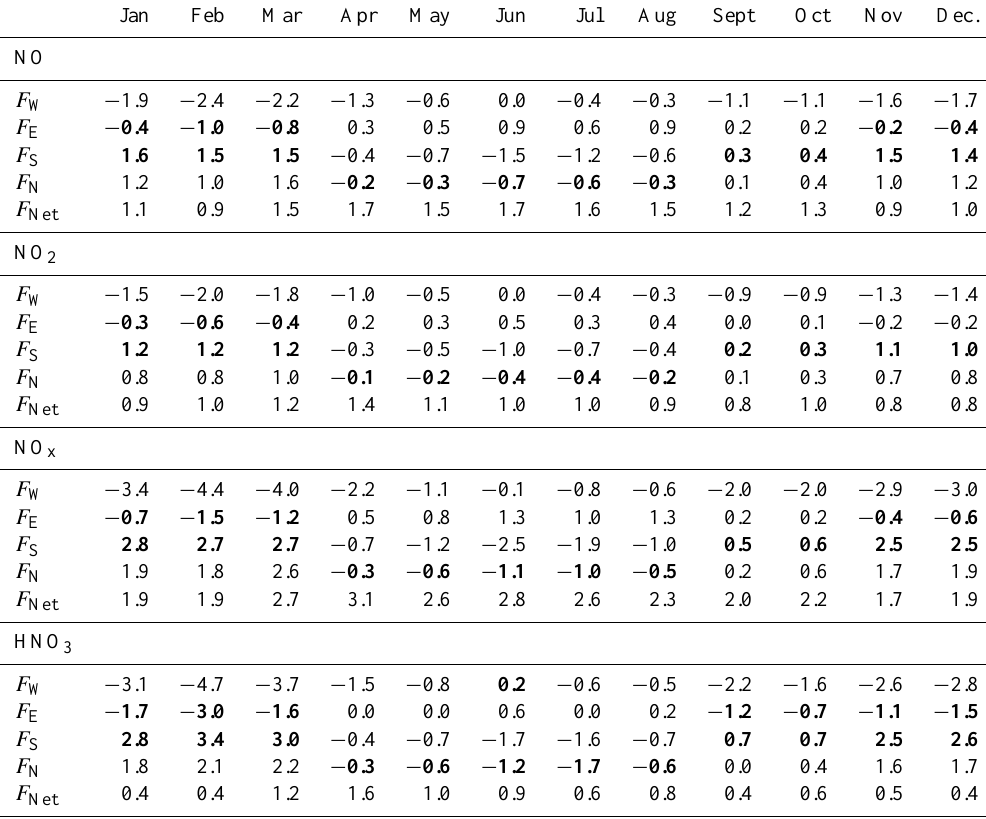
Table 1. The low-level flux budget of pollutants (NO, NO 2 , NO x and HNO 3 ) over Cape Town for each month, showing the inward and outward fluxes at the western ( F W ), eastern ( F E ), southern ( F S ) and northern ( F N ) boundaries of Cape Town and the net flux ( F Net ) over the city. A positive zonal flux ( F E or F W ) implies a westerly flux (i.e. a flux from a westerly direction), while a negative zonal flux means the opposite. A positive meridional flux ( F N or F S ) denotes a southerly flux (i.e. a flux from a southerly direction), while a negative zonal flux means the opposite. Inward fluxes (from any boundary or direction) into the city are in bold font, while outward fluxes from the city are in thin font. A positive F Net indicates divergence (i.e. depletion) of the pollutants over the city, while a negative net flux means convergence (i.e. accumulation) of the pollutants over the